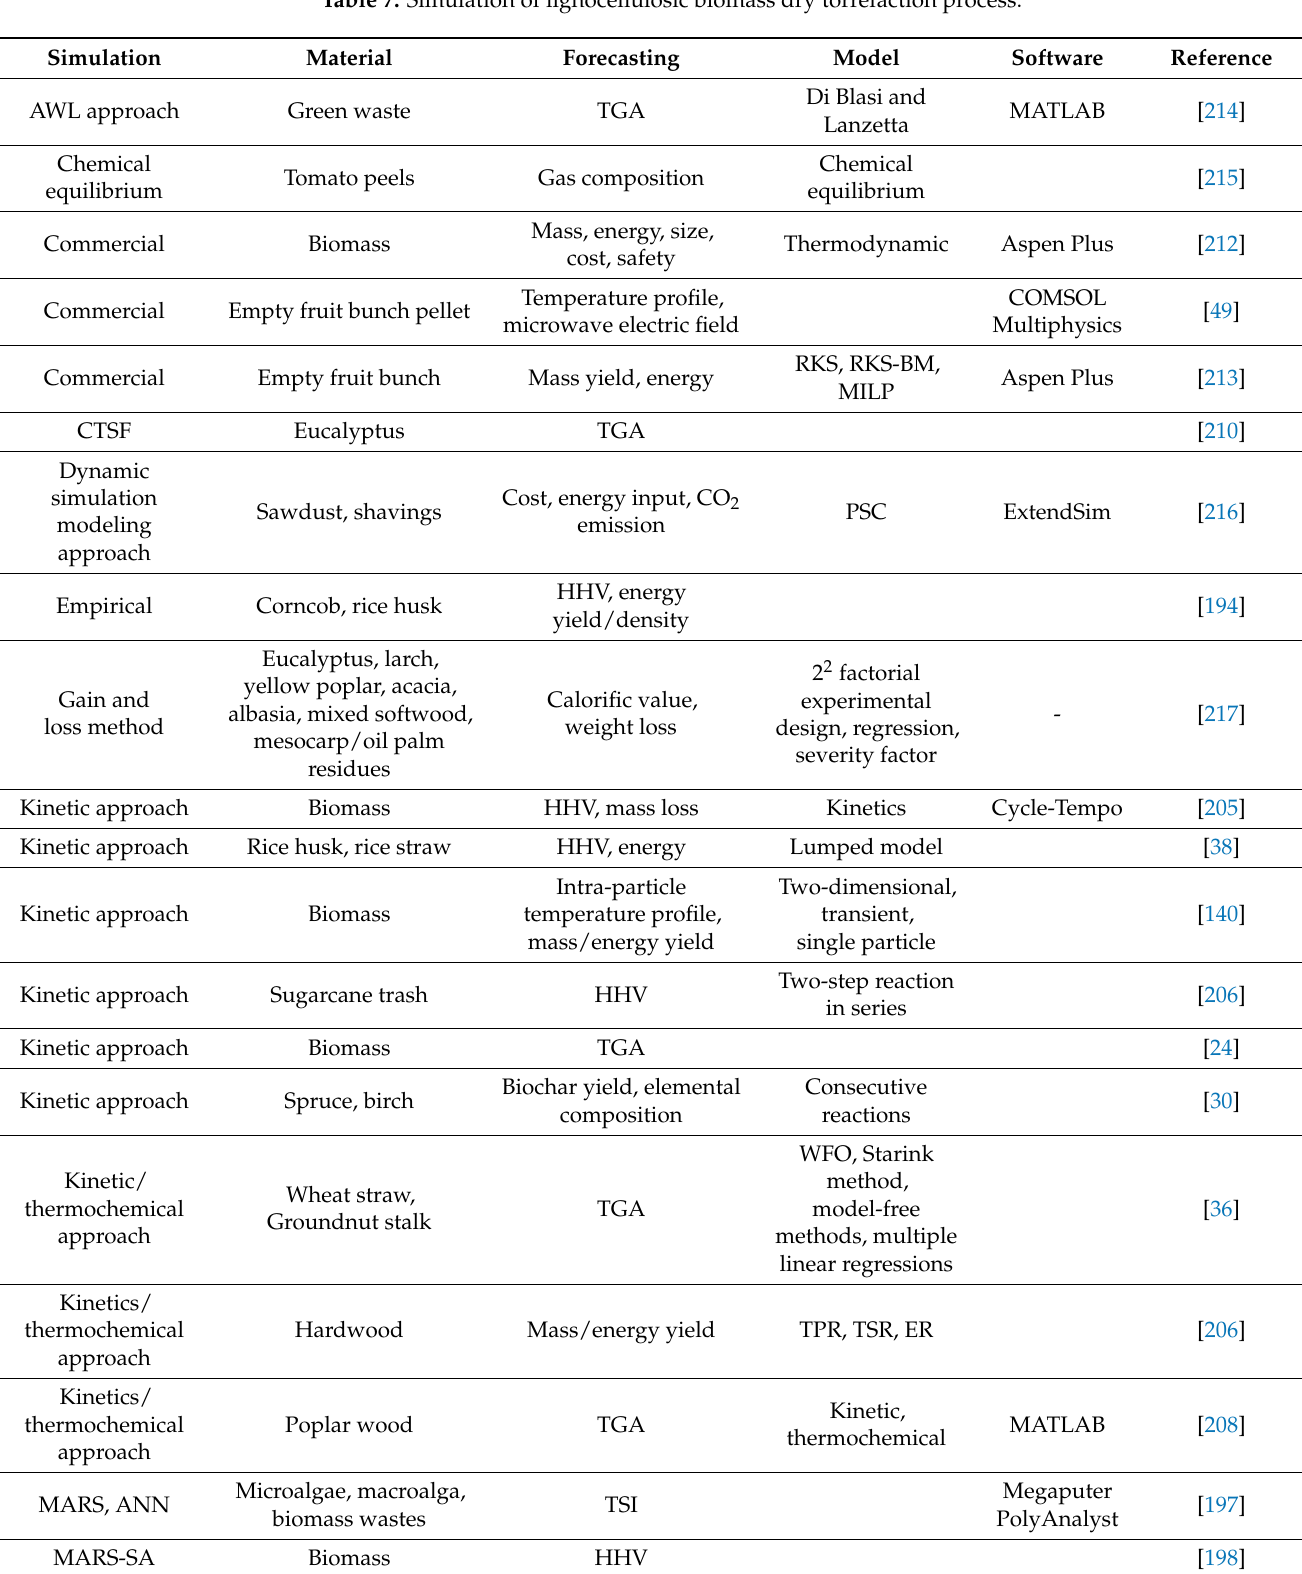
Table 7. Simulation of lignocellulosic biomass dry torrefaction